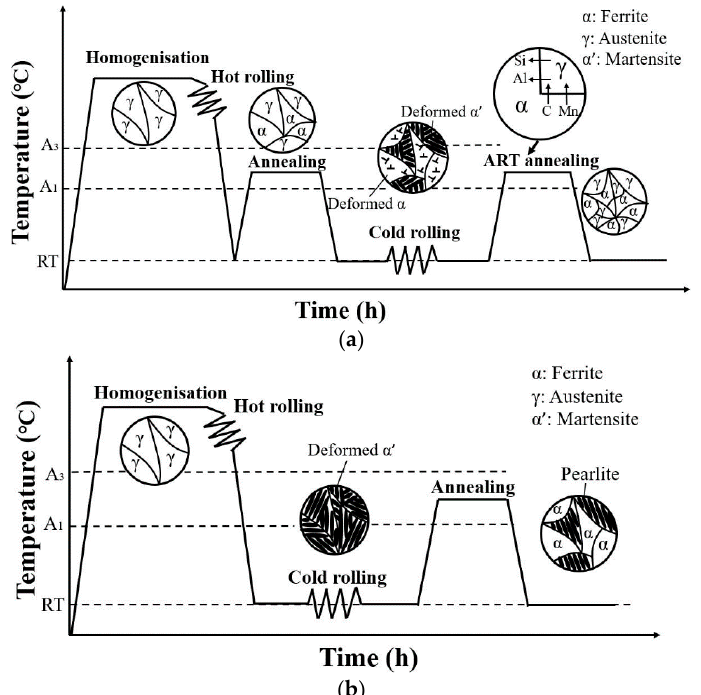
Figure 10. Schematic illustration of production processes, with evolution of microstructure, for ( a ) MMn steel and ( b ) Mn-B steel.